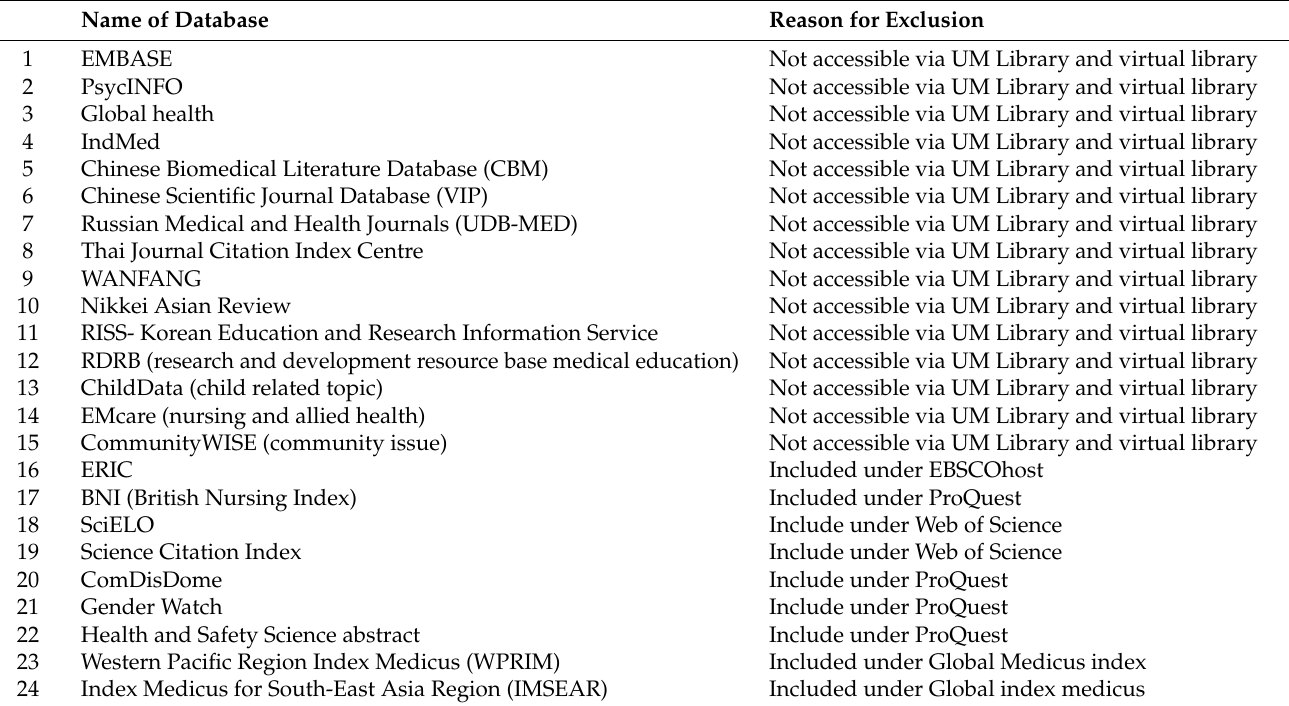
Table 7. Excluded databases and the reasons for their exclusion ( n =